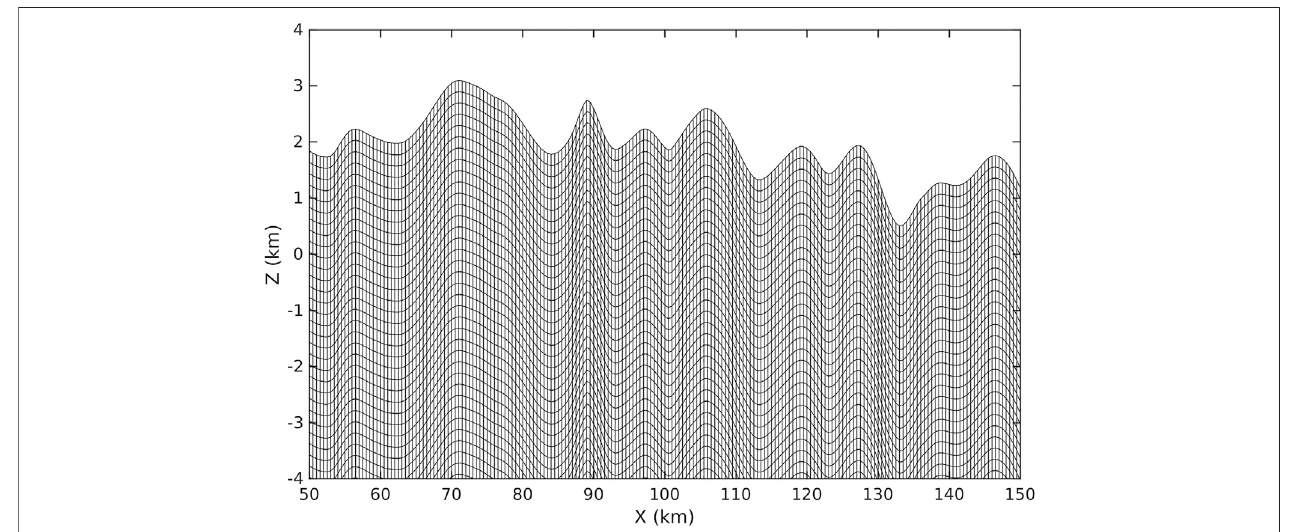
FIGURE 5 | The curvilinear grids along one vertical pro fi le (white dashed line in Figure 2 ) in the presence of the topography of the region.